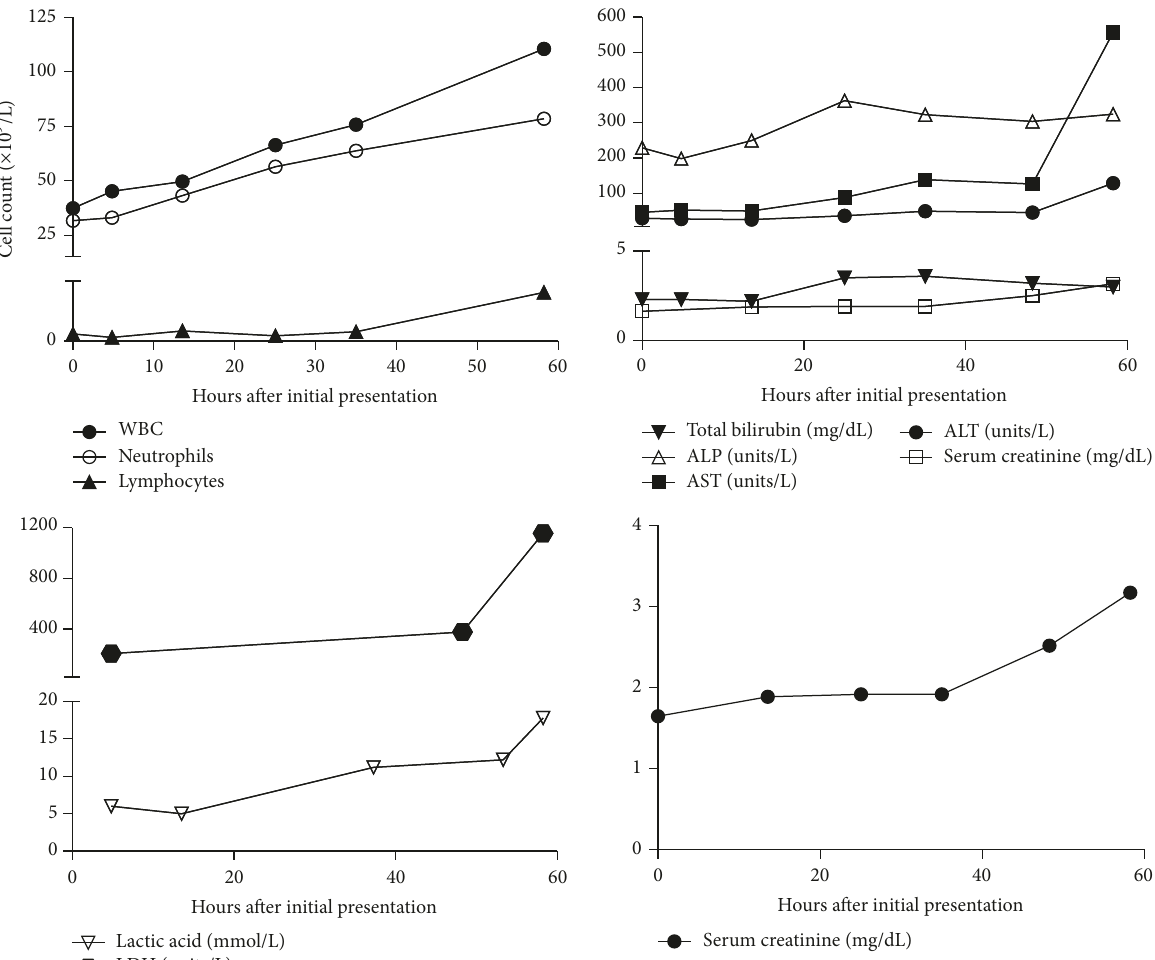
Figure 3: Laboratory parameters along the patient’s clinical course. White blood cells (WBC), absolute neutrophil counts, lymphocyte counts, renal and liver function tests, and lactic acid and lactate dehydrogenase (LDH) levels are